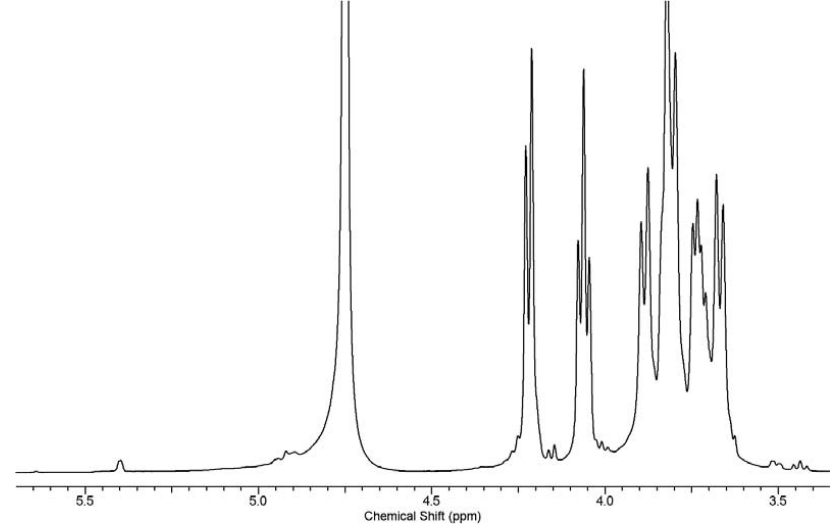
Figure 10. 1 HNMR of oxidized inulin (oxi5).